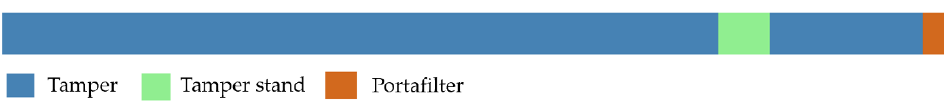
Figure 15. Example of visualization based on eye fixations: Barista education, step 10 (“Remove the coffee powder on the surface of the portafilter by hand”), pass.